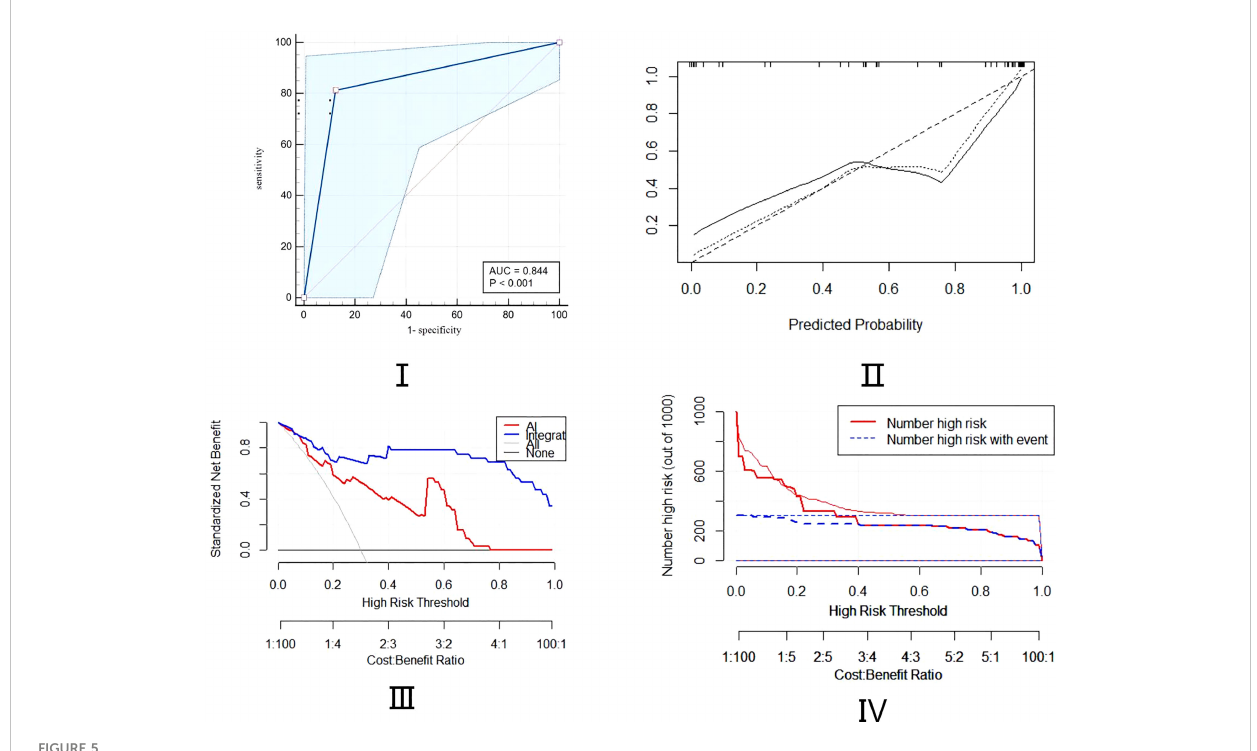
FIGURE 5 Assessment of predictive ability of the integrated model in external validation cohort using ROC, calibration, DCA, and CIC curves.